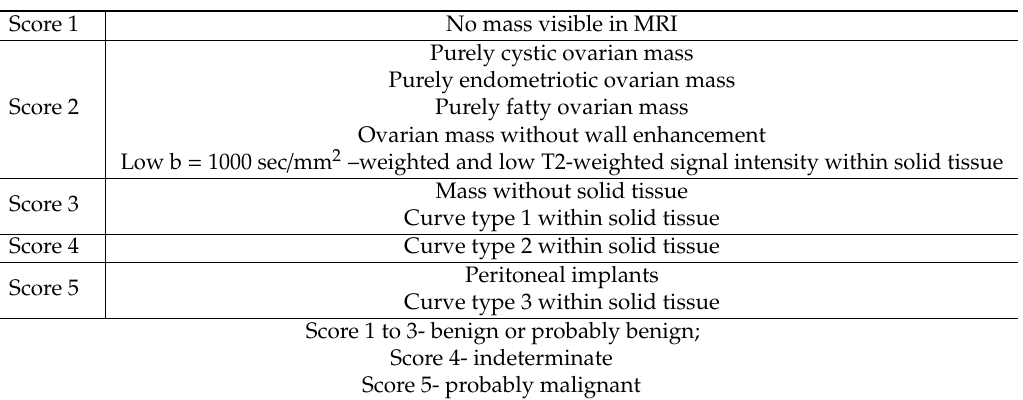
Table 3. ADNEX MR scoring system